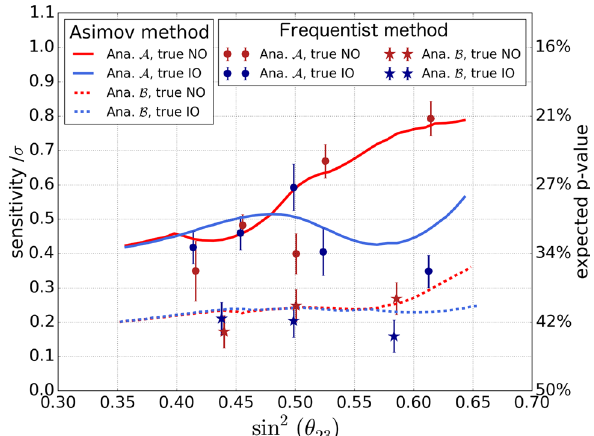
Fig. 8 Sensitivities of Analyses A and B to the NMO in terms of one- sided Gaussian sigmas (left vertical axis) and p -values (right vertical axis)derivedbytheAsimov-method(lines),andvalidatedatcertainval- ues of sin 2 (θ 23 ) using the frequentist method (markers). The statistical errors on the frequentist points arise from the finite number of PTs used due to the computationally intensive nature of the frequentist method